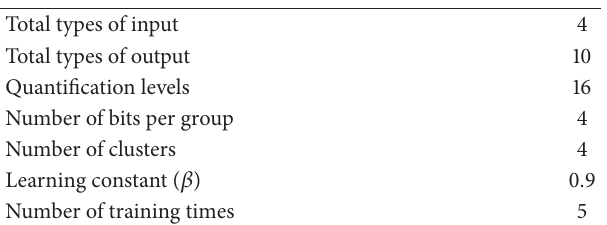
Table 2: CMAC-related parameters.